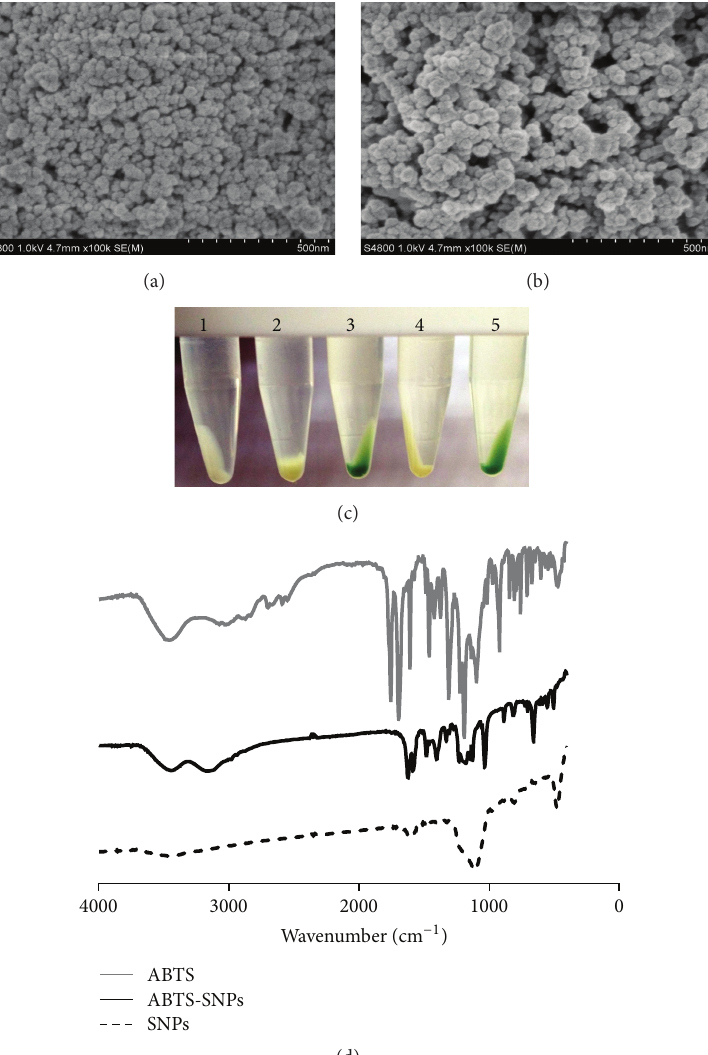
Figure 3: (a) SEM image of SNPs; (b) SEM image of ABTS-SNPs; (c) Tube 1, SNPs, Tube 2, SNPs covalently attached to ABTS, Tube 3, after reaction of ABTS-SNPs with laccase, Tube 4, regenerated ABTS-SNPs, Tube 5, after reaction of regenerated ABTS-SNPs with laccase, and (d) FT-IR spectra of ABTS, ABTS-SNPs, and